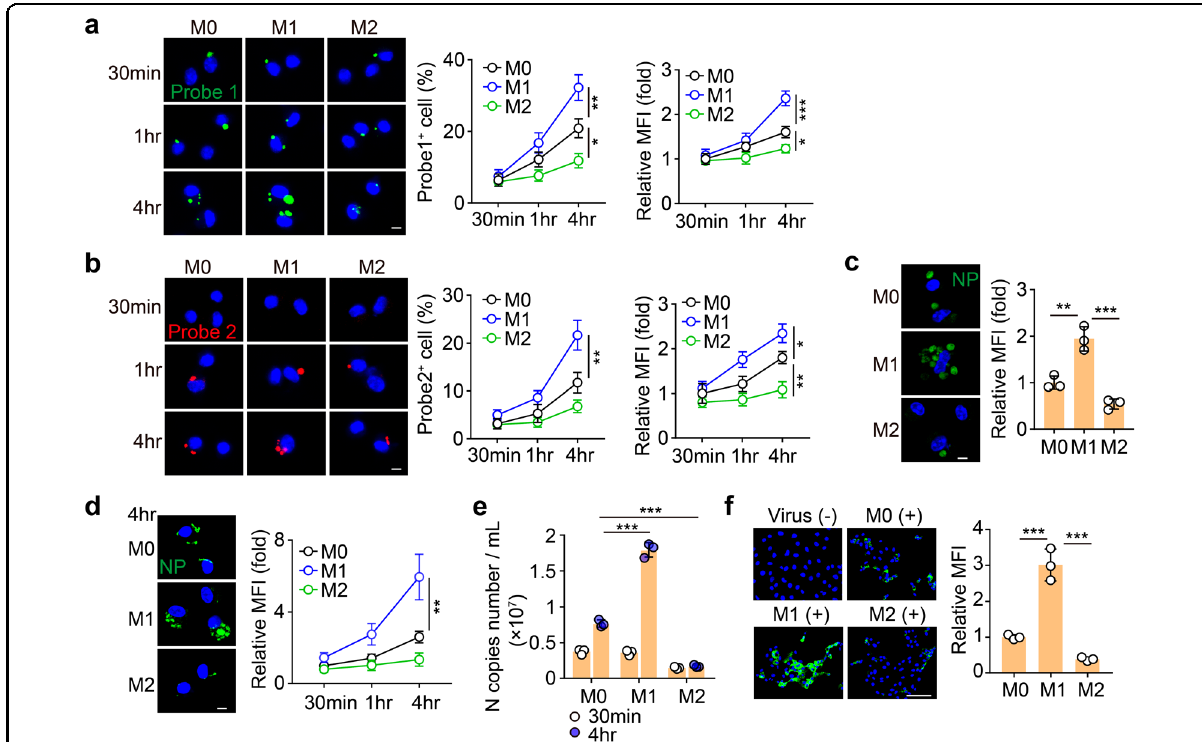
Fig. 2 SARS-CoV-2 is apt to replicate in M1 AMs. a , b M0, M1, and M2 AMs were infected with SARS-CoV-2 for 30 min. Then, the viruses were removed and the cells were cultured with a virus-free medium for another 30 min, 1 h, or 4 h. Cells were fi xed for RNAscope analysis. Probe 1 targets viral positive-sense sequence to evaluate viral distribution (green color). Probe 2 targets viral negative-sense sequence to indicate viral replication (red color). Scale bar, 5 μ m. c Same as a , except that cells were cultured with a virus-free medium for another 1 h and stained with the anti-NP antibody. Scale bar, 5 μ m. d, e Same as a , except that cells were stained with anti-NP antibody ( d ) or the viral load from the supernatants was determined by qPCR ( e ). Scale bar, 5 μ m. f M0, M1, and M2 AMs were infected with SARS-CoV-2 for 30 min. The supernatants were collected to infect Vero E6 cells for 48 h. Cells were stained with anti-NP antibodies and observed by confocal microscopy. Scale bar, 100 μ m. The data represent the mean ± SD of 3 independent experiments. * P < 0.05, ** P < 0.01, *** P < 0.001, by one-way ANOVA ( a – f